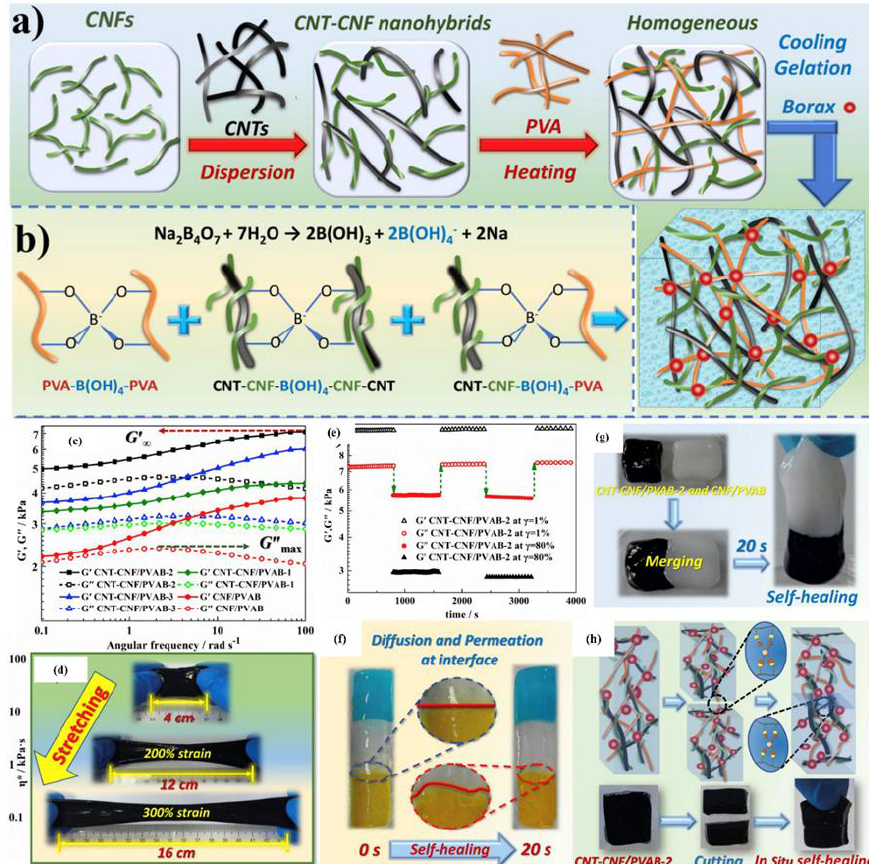
Figure 24. ( a ) Fabrication process of CNT-CNF / PVAB composite gels. ( b ) Multi-complexation between CNT-CNF nanohybrids and PVA dynamically cross-linked by borax. ( c ) G’ and G” curves as a function of ω . ( c ) η * and G* versus angular frequency ranging from 0.1 to 100 rad s − 1. ( d ) CNT-CNF / PVAB-2 hydrogel being stretched to more than 300% of the initial length. ( e ) The G″ and G′ versus time in continuous step strain of CNT-CNF / PVAB-2 composite gel. ( f ) Illustration of CNT-CNF / PVAB and CNF / PVAB hydrogels being completely merged. ( g ) Illustration of self-healing behavior for CNF / PVAB and the interfacial permeation during seal-healing. ( h ) Illustration of healing in situ for CNT-CNF / PVAB-2 gel and self-healing mechanism of composite gels [203]. Polymers 2020 , 12 , x FOR PEER REVIEW 45 of 63